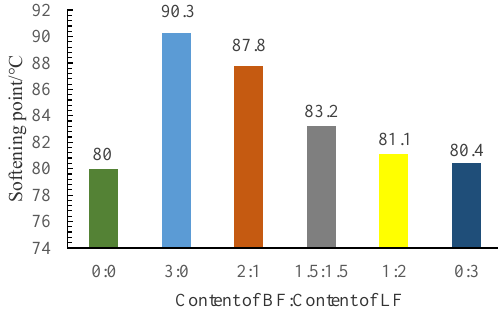
Figure 8. Test results of the softening point.